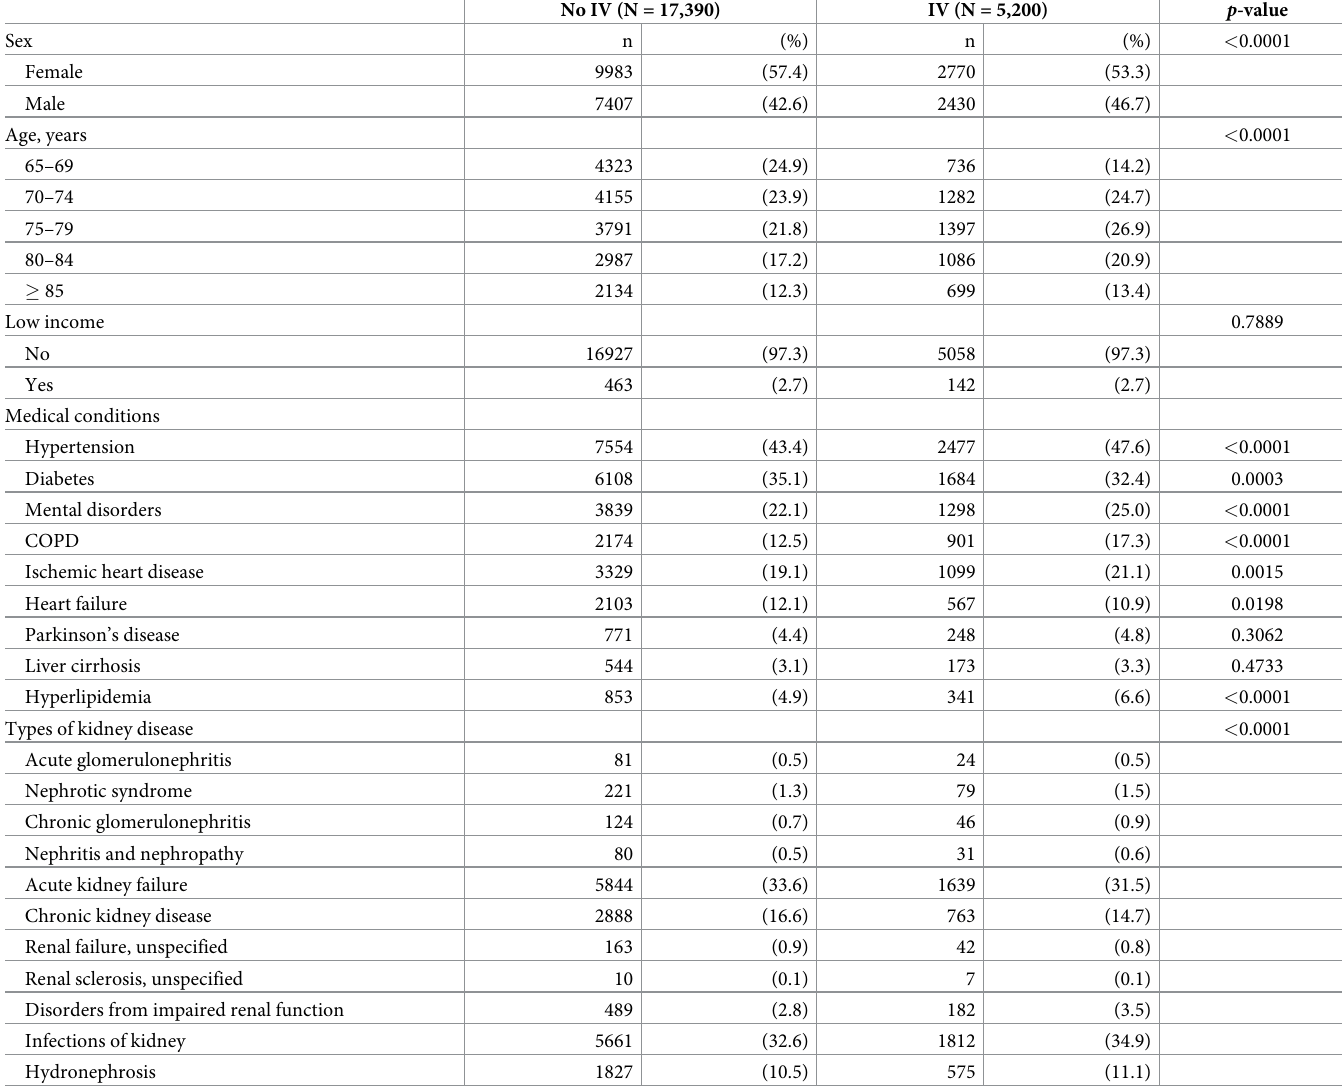
Table 1. Characteristics of hospitalized kidney disease patients with and without influenza vaccination (before